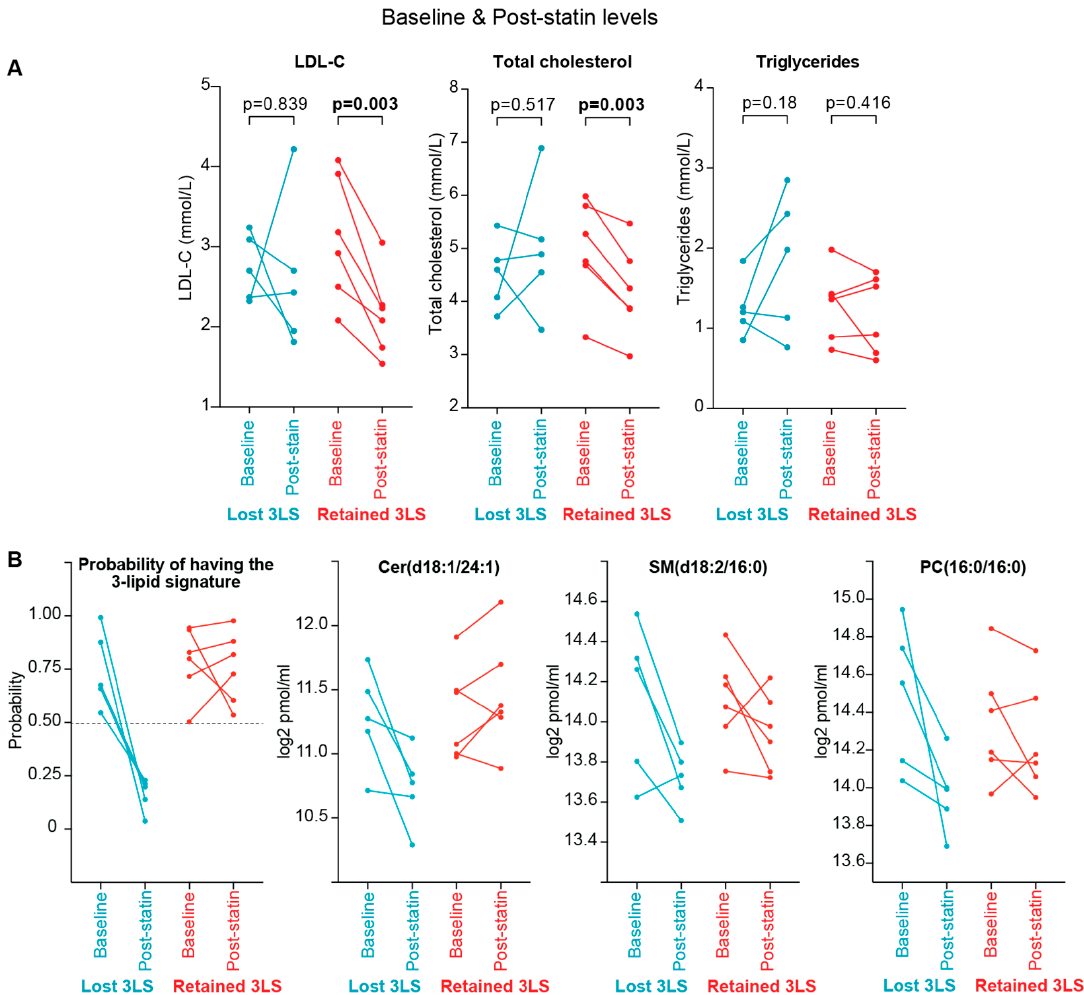
Figure 3. Baseline and post-simvastatin status of clinical lipids and the 3-lipid signature in men who lose the 3-lipid signature and those who keep the 3-lipid signature: ( A ) plasma levels of LDL-C, total cholesterol, and trigylceride levels, as measured on a clinical assay (paired t-test); ( B ) probability of having the 3-lipid signature (calculated by the logistic regression model), and plasma levels of the three lipids of the 3-lipid signature.